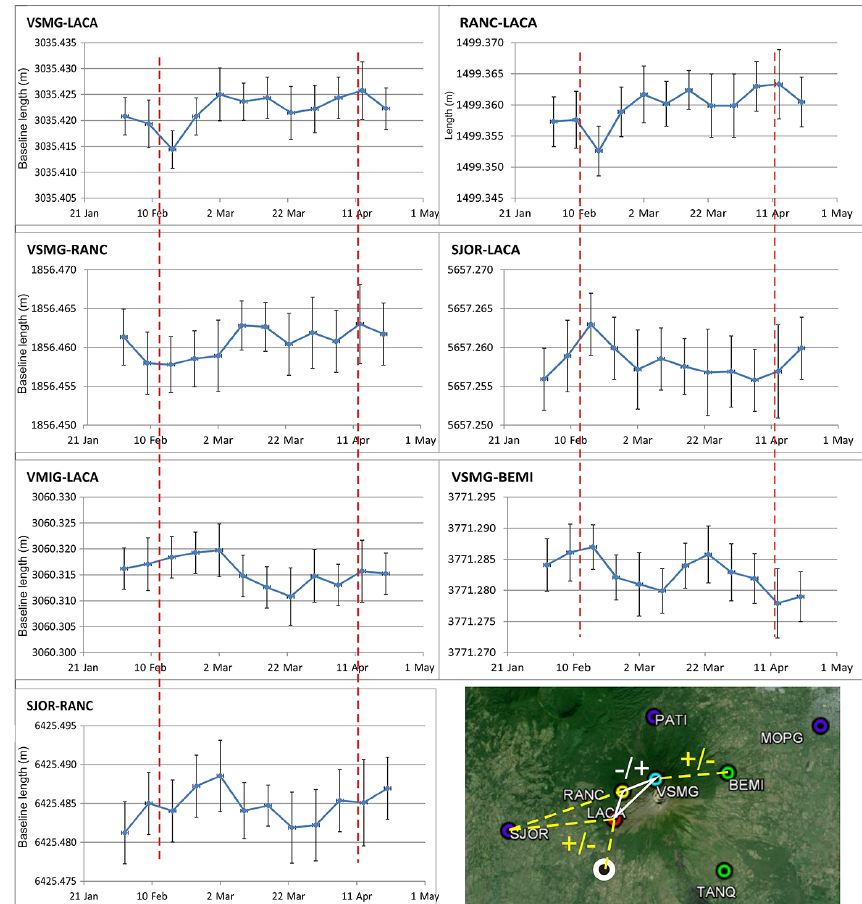
Figure 11. Baseline length variations (meters) evidencing the dynamics mainly affecting the summit part of the volcano. The map shows the location and kinematics of the baselines: when only the summit part extends (white solid lines), this produces contraction on the lower flanks (yellow dashed lines) and vice